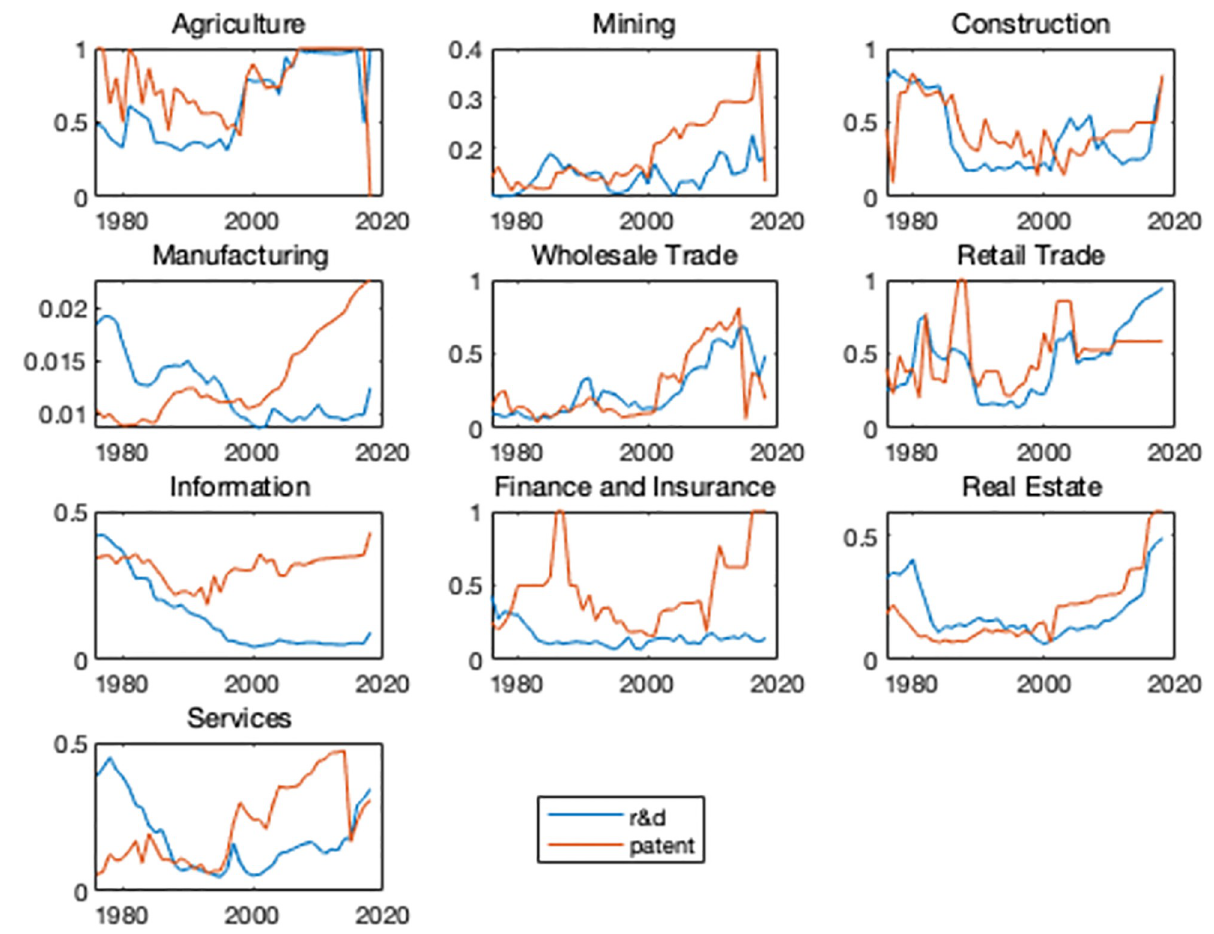
Fig 3. Industry-level HHI of R&D and